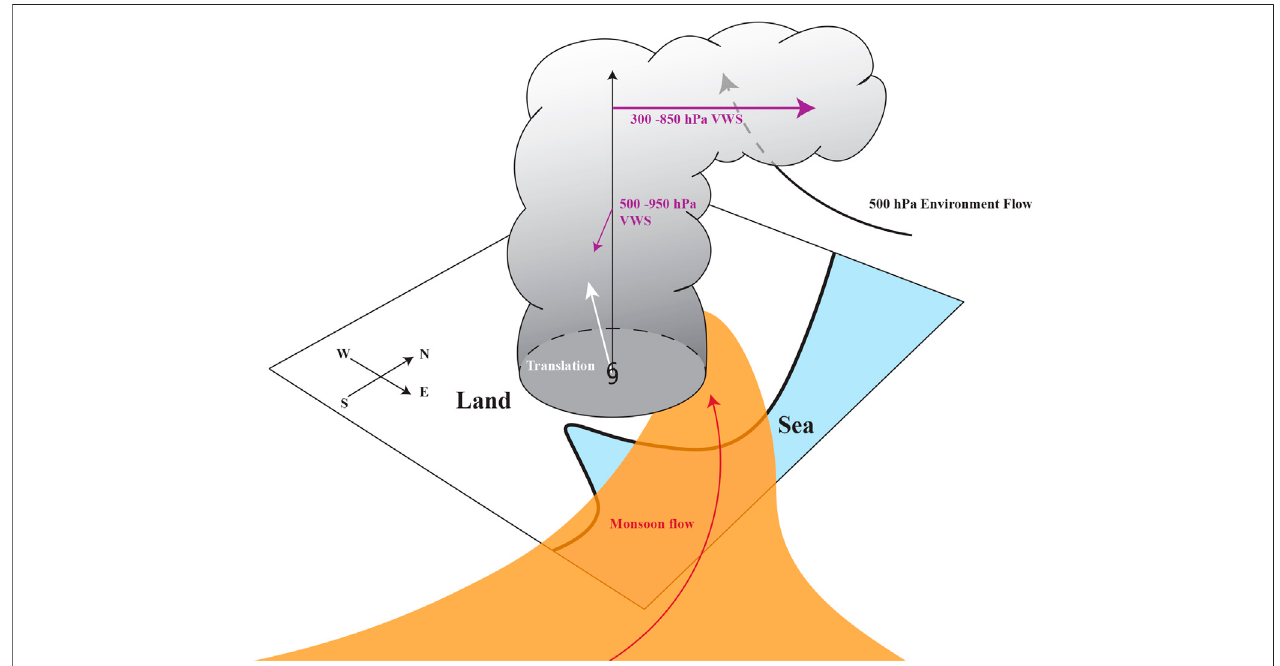
FIGURE 15 | Schematic illustration of asymmetric rainfall evolution in Rumbia. The purple arrows indicate the 300 – 850 hPa VWS and 500 – 950 hPa VWS. The white arrow shows the TC translation direction. The black and red streamlines represent the 500 hPa environmental fl ow and the 850 hPa monsoon fl ow, respectively. The yellow area indicates the high energy air mass transported into the heavy rainfall region from the South China Sea and the western North Paci fi c by the low-level monsoon fl